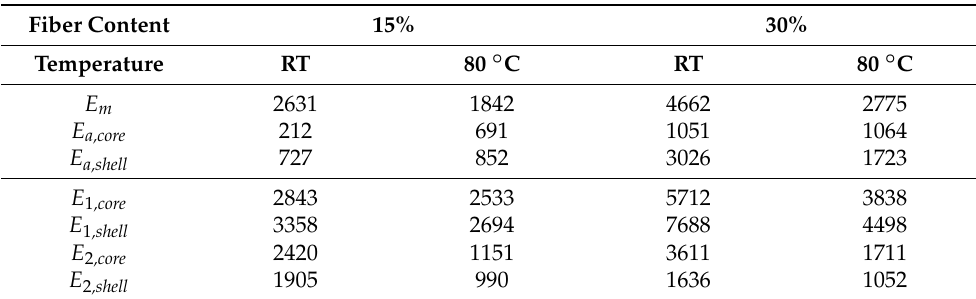
Table 2. Analytical results of the anisotropic modulus in the MPa of the core and shell layers in the material coordinate